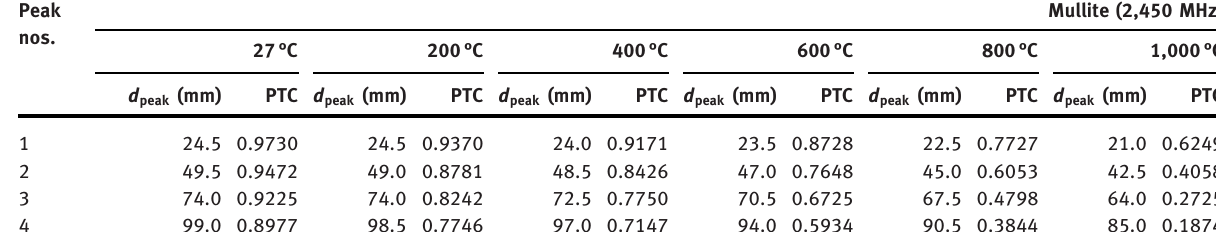
Table 2: Transmission peak positions in the PTC of mullite and Al 2 O 3 ceramics at various temperatures. Peak